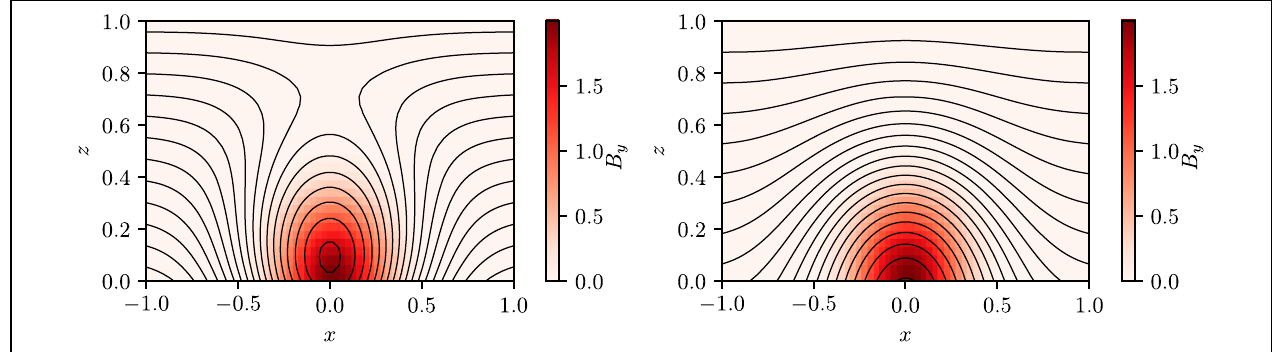
FIGURE 11 | Comparison between two magnetic arcades with overlying magnetic fields in opposite directions. The black lines represent the magnetic field projected into the ( x , z ) plane and the heatmap represents the magnetic field strength out of this plane.